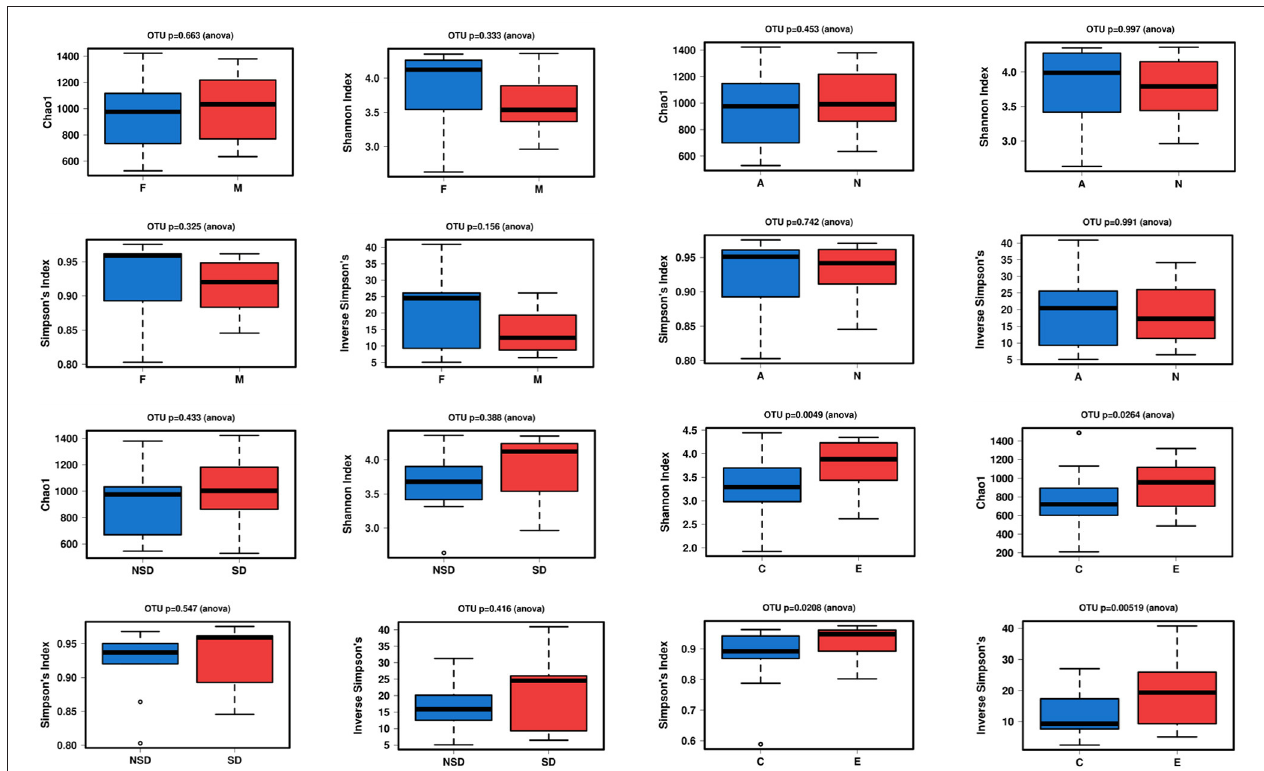
FIGURE 1 | Alpha diversity between two groups with Chao1, Shannon, Simpson’s, and inverse Simpson’s indexes. (Significance is denoted by p < 0.05. The abnormal value is shown as